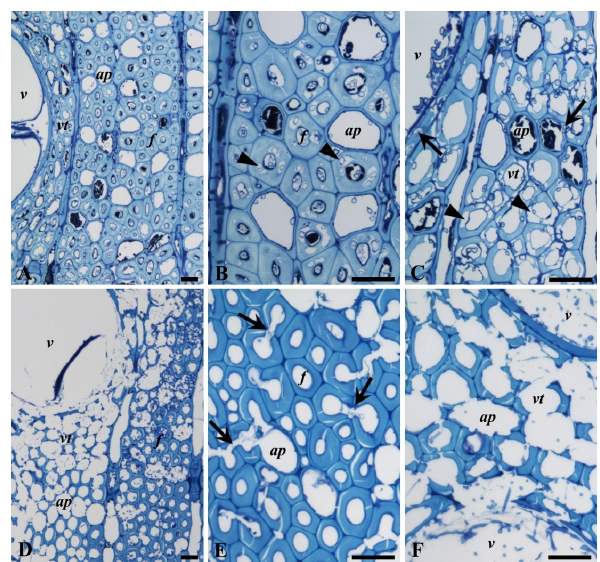
Figure 9. LM observations of oak wood decayed by P. ostreatus and T. versicolor . ( A – C ) Decay by P. ostreatus showing numerous cavities (arrowheads) in the secondary cell wall of (libriform) fibers ( f , B ) and (vasicentric) tracheids ( vt , C ). Cavities were frequently coalesced, with only remaining innermost cell walls ( C ). Note formation of cavities in the vessel ( v ) and axial parenchyma ( ap ) cell wall (arrows in C ). ( D – F ) Decay by T. versicolor showing the degradation of fibers ( E ) and trachieds ( C ) by thinning of secondary cell wall from the lumen outwards. Note degradation of fibers through pits (arrows in E ) and advanced stages of decay in the vessel and axial parenchyma cell walls ( D , F ). Scale bars: 20 µm. The patterns of cell wall degradation are more clearly resolved in the TEM images for P. ostreatus (Figure 10) and T. versicolor (Figure 11). Cavity formation was detected in secondary cell walls of Microorganisms 2020 , 8 , x FOR PEER REVIEW fibers and tracheids decayed by P. ostreatus (asterisks in Figure 10). Cavities were frequently coalesced in the secondary cell wall with remnants of the innermost cell wall, including the S3 layer, apparent (arrows in Figure 10B–D). Electron-dense materials formed around hyphae and decayed cell wall regions were present in cavities (arrowheads in Figure 10A–C). The electron-dense materials in cavities may represent a mixture of melanin trapped in extracellular slime and lignin residues, while fungal hyphae within the cell lumen may be applied with extractives. The coating of the S3 layer with a dense material (most likely extractives) may explain why this layer is seen intact in places despite extensive degradation of the underlying secondary cell wall. Some signs of fungal decay through intercellular spaces were detected by P. ostreatus , but decay did not progress over the MLs (Figure 10D and inset) in the wood samples examined . Intercellular spaces between fibers and between tracheids associated with axial/ray parenchyma cells are frequently detected in English oak ( Q. robur ) [49].